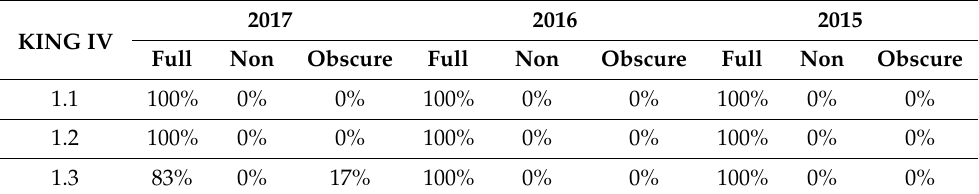
Table 2. Risk governance structure